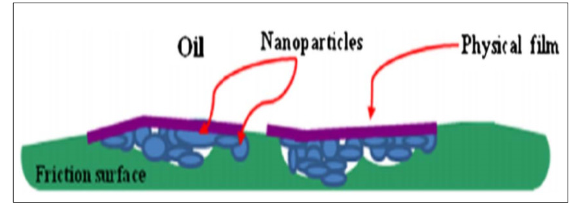
Fig. 1. Mechanism appearing how to reduce friction between oil surfaces when mixed with nanoparticles [34].